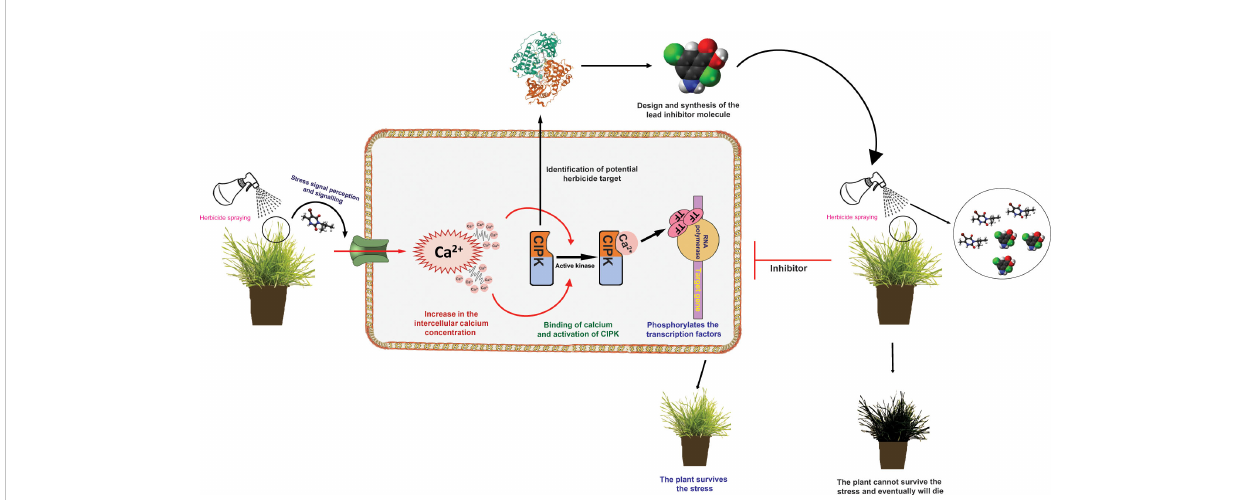
FIGURE 1 Schematic diagram showing the possible role of calcium (Ca 2+ ) signalling in weeds in herbicide resistance. The resistant plant (R) survives the herbicide stress by target site and non-target site mechanisms. The hypothesis is that upon perceiving and transducing the herbicide stress signals, there might be an abnormal elevation of the Ca 2+ ions within the cytoplasm of the cell. This initiates the calcium signalling pathways. The Ca 2+ ions are thought to bind to the sensor responder proteins and activate their kinase activities. Instead, these kinases activate the transcription factors by phosphorylating them, thus leading to the overexpression of the stress-responsive metabolism-related genes. In turn, these genes enhance the herbicide metabolism process, conferring resistance in R plants. Following the identi fi cation and validation of the potential herbicidal targets (e.g., CIPK isoforms), computer-aided drug design can be used to identify and screen the new inhibitors, which might contribute to the novel herbicidal lead compound